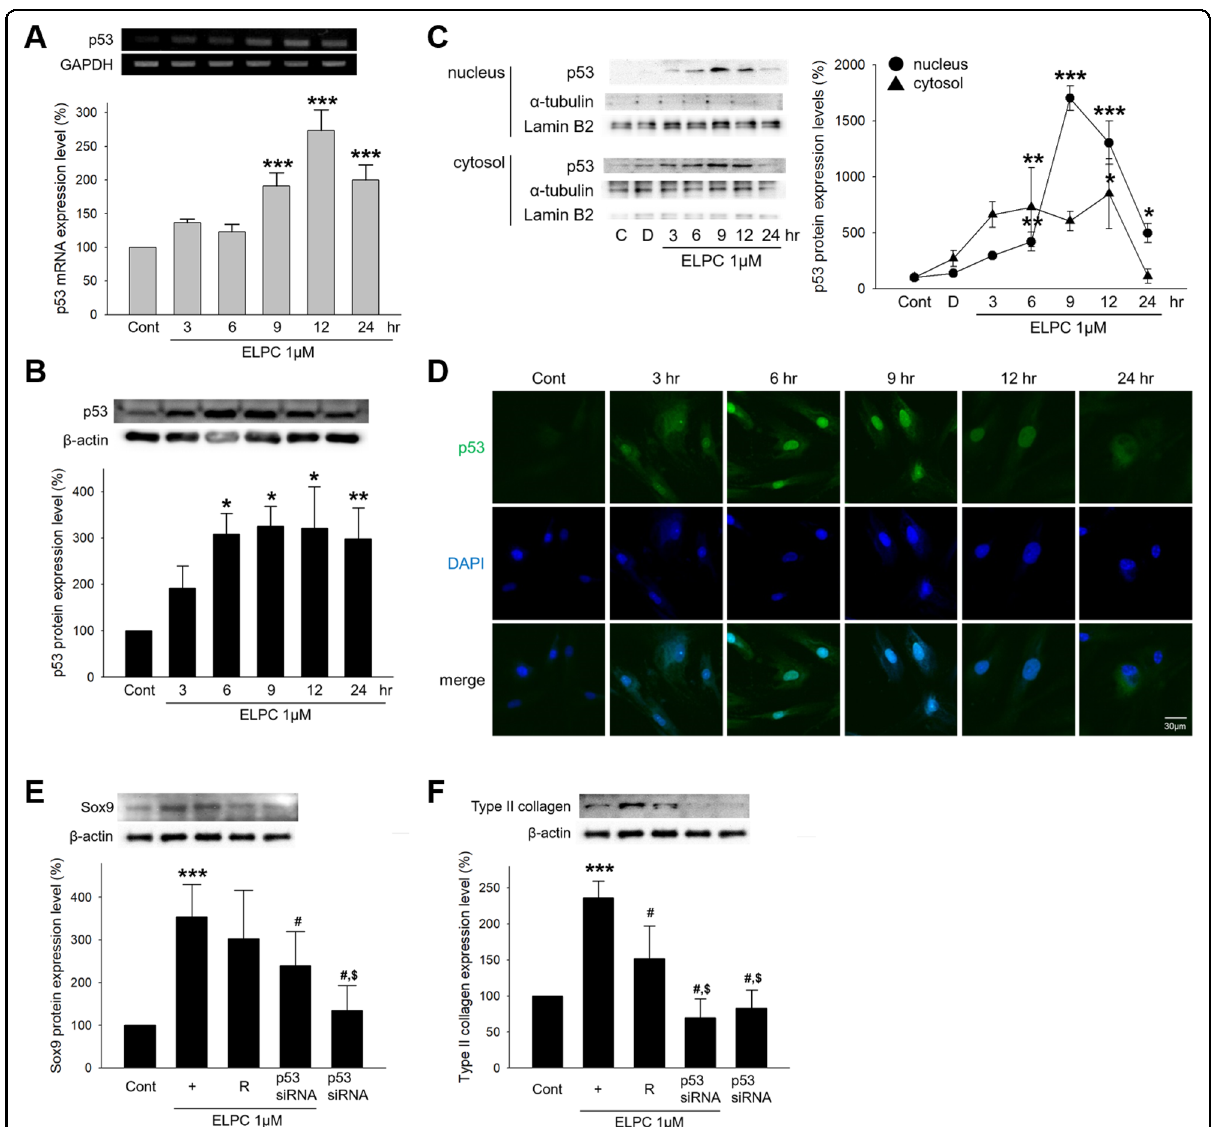
ASCs treated with ELPC for 24 h were separated into the nuclear and cytosolic fractions. p53 was quanti fi ed and normalized to Lamin B2 and α - tubulin in the nucleus and cytosol, respectively. Cont Control, D DMSO-treated ASCs. * p < 0.01 ** p < 0.05 *** p < 0.001 compared to the control. n = 3. d The translocation of p53 was con fi rmed by immuno fl uorescence staining. p53 was detected by FITC green fl uorescence. The nucleus was